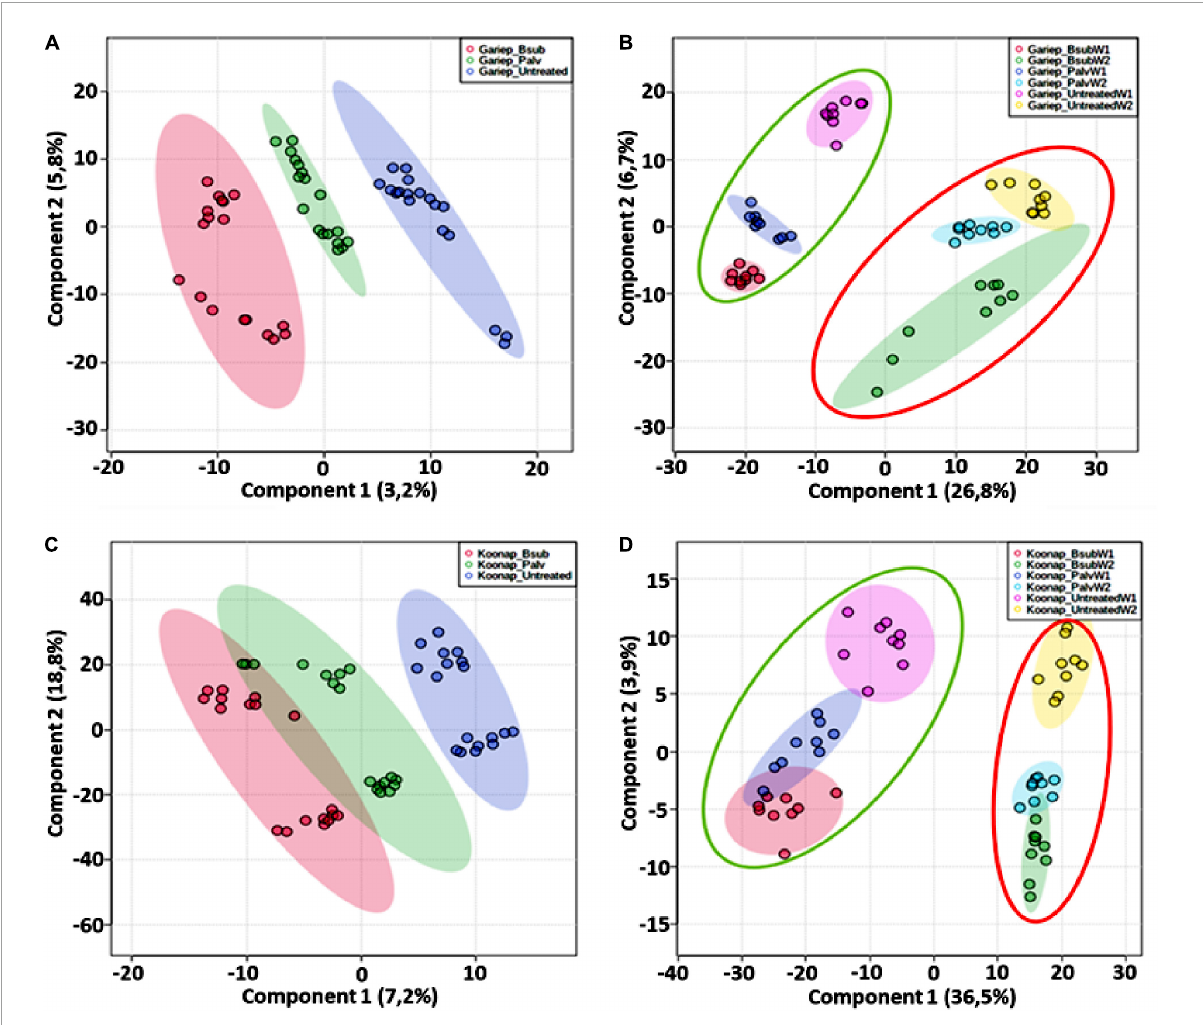
FIGURE6 General characterization of the impact of plant growth-promoting rhizobacteria (PGPR) treatment on the overall leaf metabolome of wheat cultivars. (A) PLS-DA scores plot showing the global differences in the metabolite profiles from leaf extracts resulting in separation of PGPR-treated (red = Gariep_ B. sub , green = Gariep_ P. alvei ) and untreated (blue). (C) PLS-DA scores plot showing the global differences in the metabolite profiles from leaf extracts resulting in separation of PGPR-treated (red = Koonap_ B. sub , green = Koonap_ P. alvei ) and untreated (blue). (B,C) Shows the time-dependant clustering/separation of samples from PGPR-treated and untreated Gariep and Koonap cultivars from week 1 (green demarcation) and week 2 (red demarcation) of samples harvesting and extraction. The scores plots reveal the differential regulation of the leaf metabolome resulting from the varying rhizosphere bacterial treatments and the potential response mechanisms of the different cultivars over time. The data projected above were median-normalized, log transformed and Pareto -scaled in MetaboAnalyst for correlation and predictability ratings of R 2 = 0.961 and Q 2 = 0.578 (A) ; R 2 = 0.852 and Q 2 = 0.606 (B) ; R 2 = 0.920 and Q 2 = 0.418 (C) ; and R 2 = 0.903 and Q 2 = 0.606 (D) .